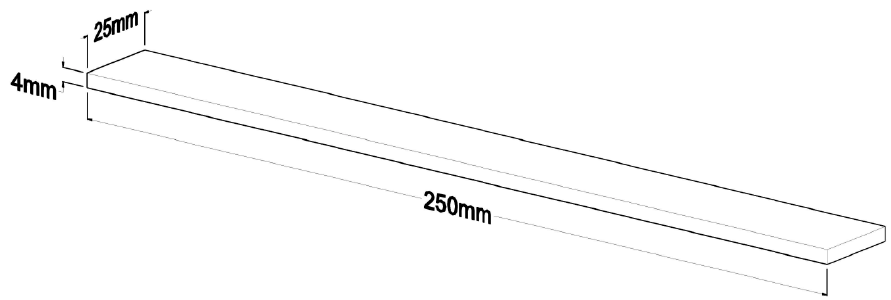
Figure 2. Tensile samples dimensions.